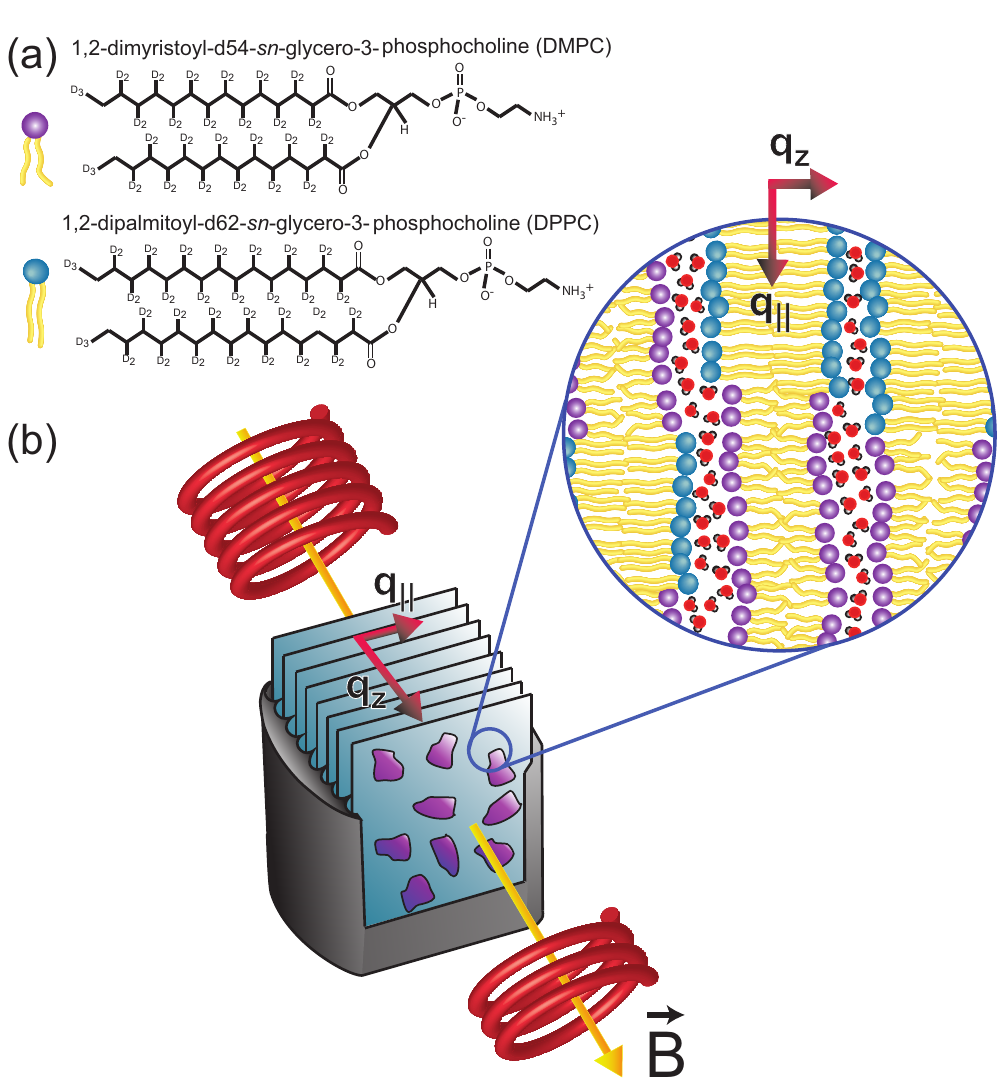
Figure 1. ( a ) Schematic representations of the DMPC and DPPC molecules used to prepare the synthetic membranes for this study. ( b ) Sketch of the scattering geometry: Highly oriented, multi- lamellar membranes were applied on silicon wafers. Eighteen such wafers were mounted inside of a 3.5 T horizontal cryomagnet for the neutron diffraction experiments. Out-of-plane and in-plane structures of the membrane were studied separately but simultaneously. The magnetic field vector, (cid:126) B , was parallel to the out-of-plane and in-plane scattering vectors, q or q z ||